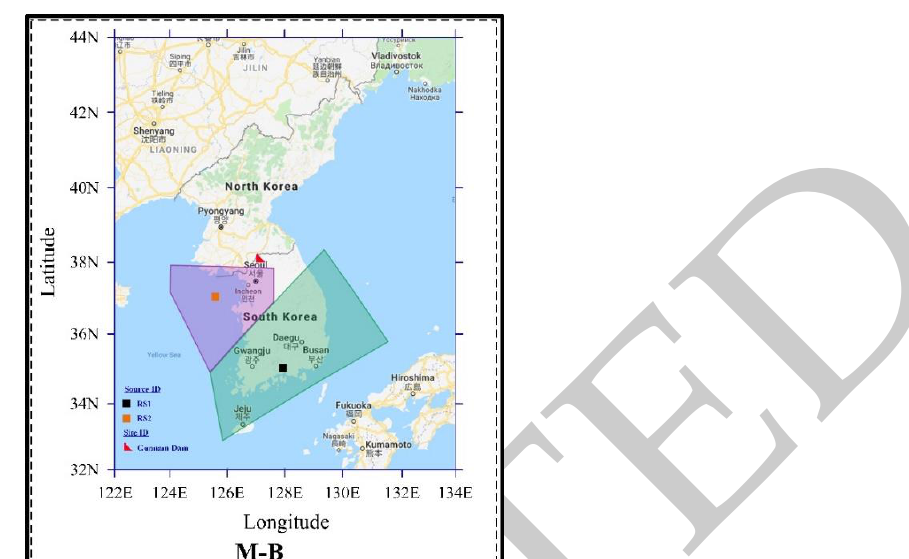
Figure 16. Seismic source model for probabilistic seismic hazard analysis of South Korea showing the affected area of earthquakes produced by accounting more than 1800 historical earthquakes records. The boxes indicate the source identification; the transparent portions show the boundary of the affected area and the dam icon focuses on the site location on the map.